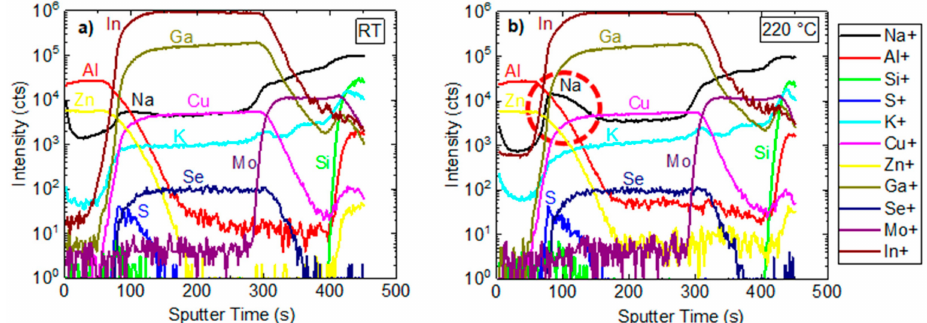
Figure 5. ToF-SIMS depth profiles performed with oxygen sputtering source on complete CIGS solar cells with stacking sequence ZnO:Al / i-ZnO / In x S y / CIGS / Mo / glass. ( a ) Solar cell with 7.1% e ffi ciency and In x S y bu ff er deposited at RT; ( b ) Solar cell with 14.6% e ffi ciency and In x S y sputtered at 220 ◦ C substrate temperature. The enhanced sodium signal is highlighted with a dashed red